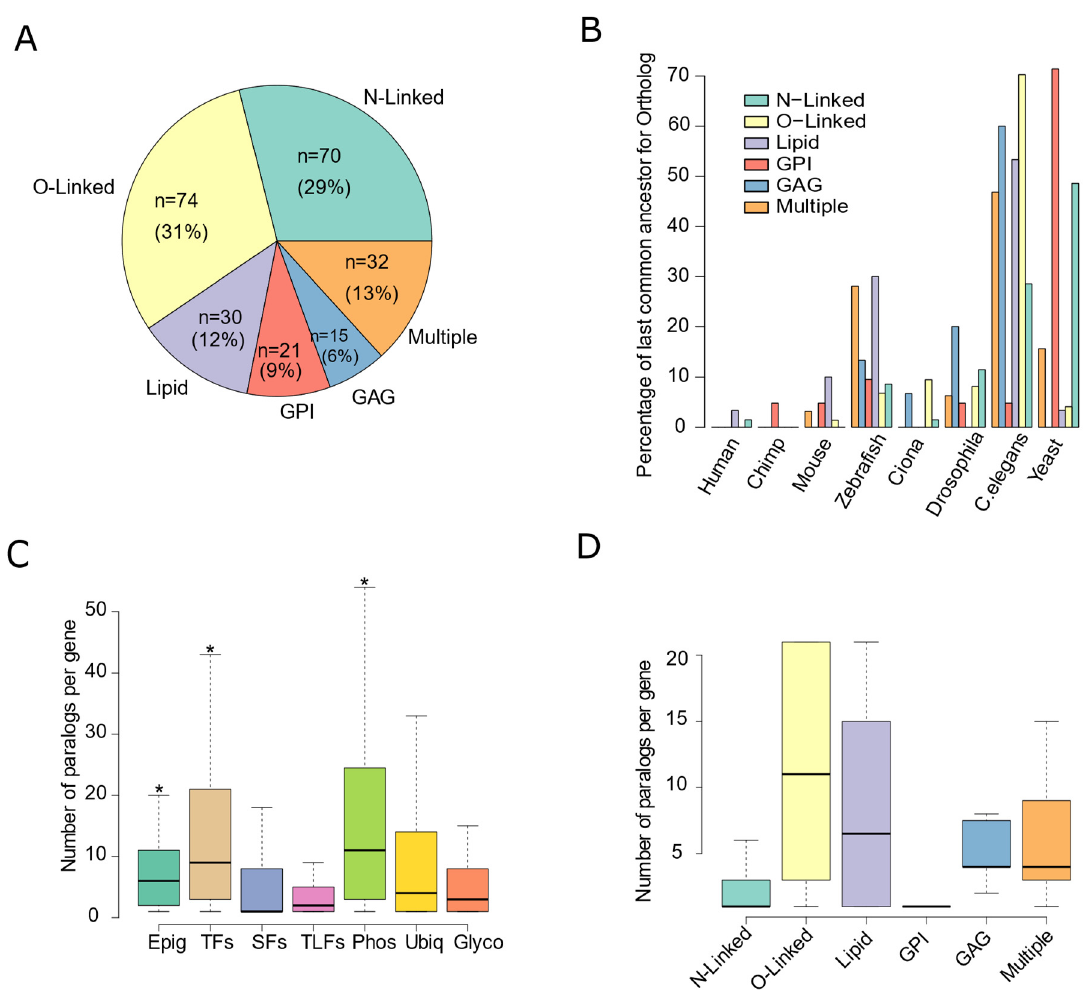
Figure 1. Glycosylation Factors are an evolutionarily conserved family of genes. ( A ) Pie chart with the frequencies of each glycosylation pathway among the 242 genes considered in this study: N-linked; O-Linked; Lipid; Glypiation (GPI); Glycosaminoglycans (GAG); Genes involved in more than one pathway (Multiple). ( B ) Barplot with the percentages of the organism representing the last common ancestor to the human gene, for each glycosylation subclass. ( C ) Boxplot of the total number of paralogous copies per gene, for each class of gene expression regulators: epigenetic (Epig); transcription (TF); Splicing (SF); Translation (TLF); Phosphorylation (Phos); Ubiquitination (Ubiq); Glycosylation (Glyco). An asterisk (*) represents that the number of paralogs per gene in the class is significantly different from glycosylation (Wilcoxon Test p < 0.05). ( D ) Boxplot of the total number of paralogous copies per gene for each glycosylation subclass .